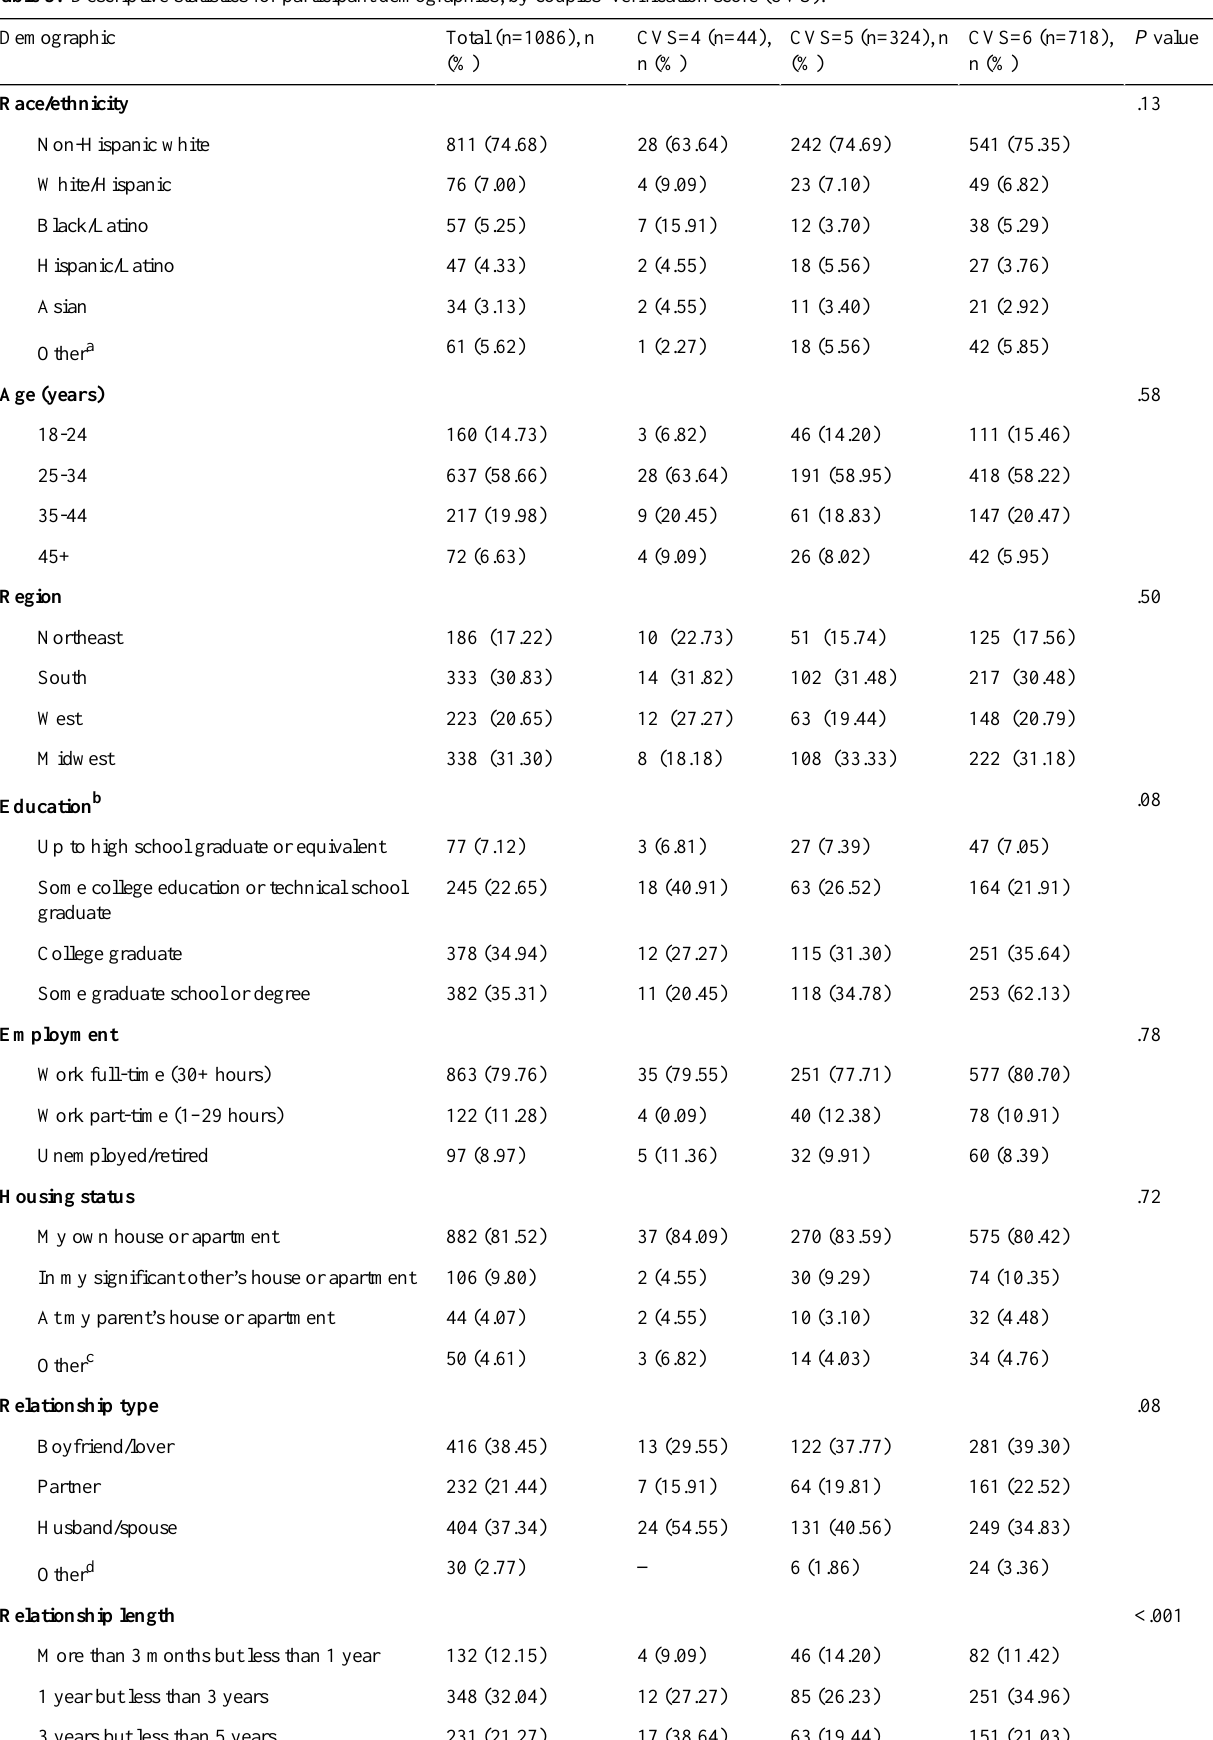
Table 3. Descriptive statistics for participant demographics, by couples’verification score (CVS).